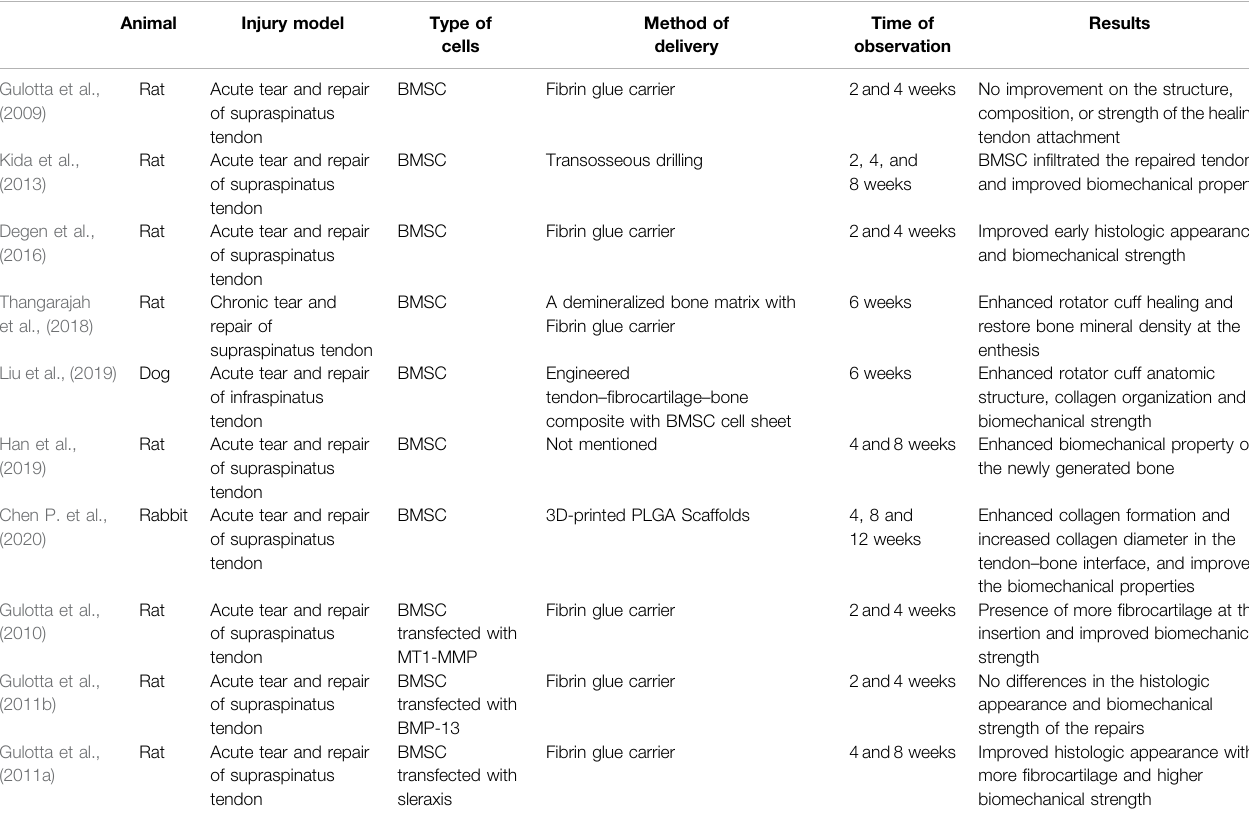
TABLE 1 | Summary of bone marrow mesenchymal stem cells for rotator cuff injuries.